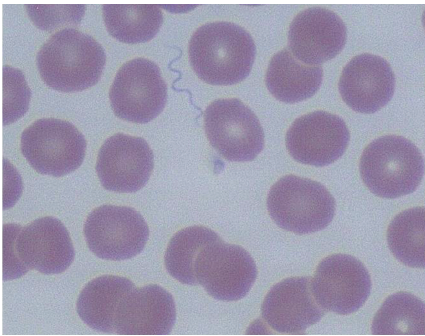
Figure 1: Loosely coiled Borrelia sp. in a thin peripheral blood smear stained with Wright-Giemsa stain and visualized under oil immersion ( × 500).